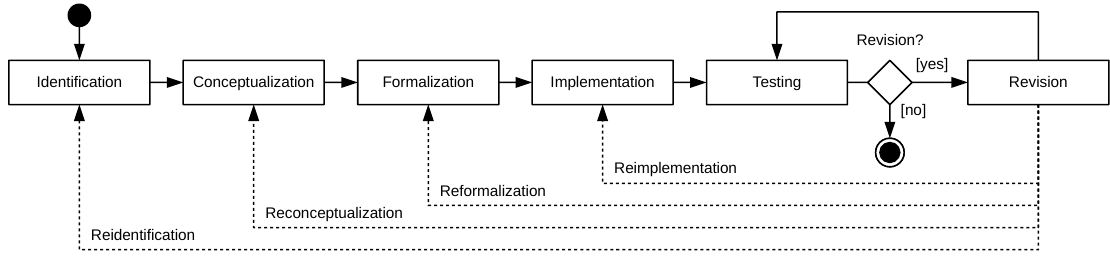
Figure 3. Applied variant of a classical knowledge engineering process, adapted from [32].